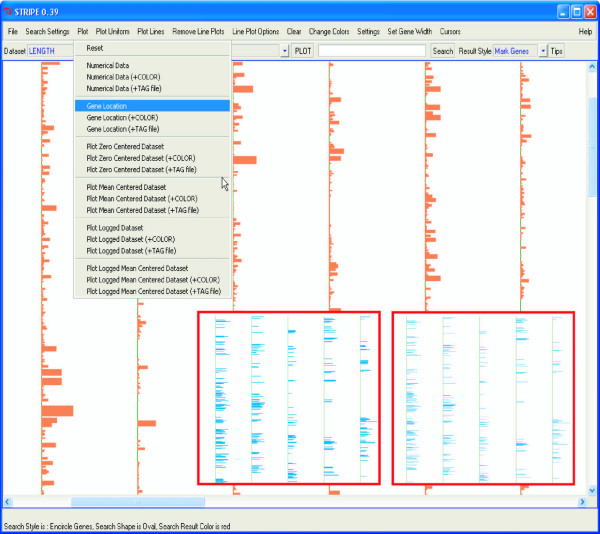
A zoomed in view of a few chromosomes is shown here. The plot menu shows the different choices for plotting a bar-chart in STRIPE. The two insets show a comparison between plotting data with (left inset) and without gene lengths (right inset) respectively, scaled along the chromosome. It is possible to plot the genes on the chromosomes in two ways, one in which the gene length is accurately scaled along the chromosome (giving the appearance of thick lines, which may be misunderstood for clusters of genes), and another in which the gene lengths are ignored and a line is drawn at the exact center of the gene. The latter gives a better view and helps avoid the misunderstanding that there are clusters. This is helpful in visual identification of possible gene clusters.